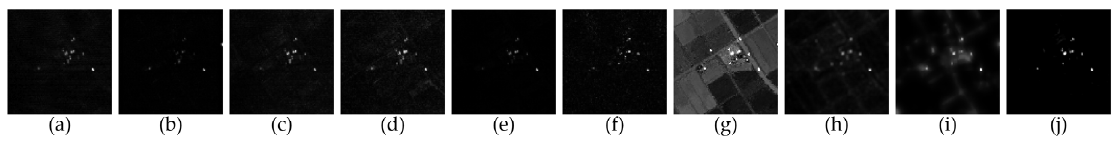
Figure 11. The detection results of different methods on the Chikusei dataset: ( a ) RX; ( b ) LRX; ( c ) LSMAD; ( d ) LSDM–MoG; ( e ) CDASC; ( f ) 2S–GLRT; ( g ) BFAD; ( h ) SSFSCRD; ( i ) AED; ( j ) SCDF.